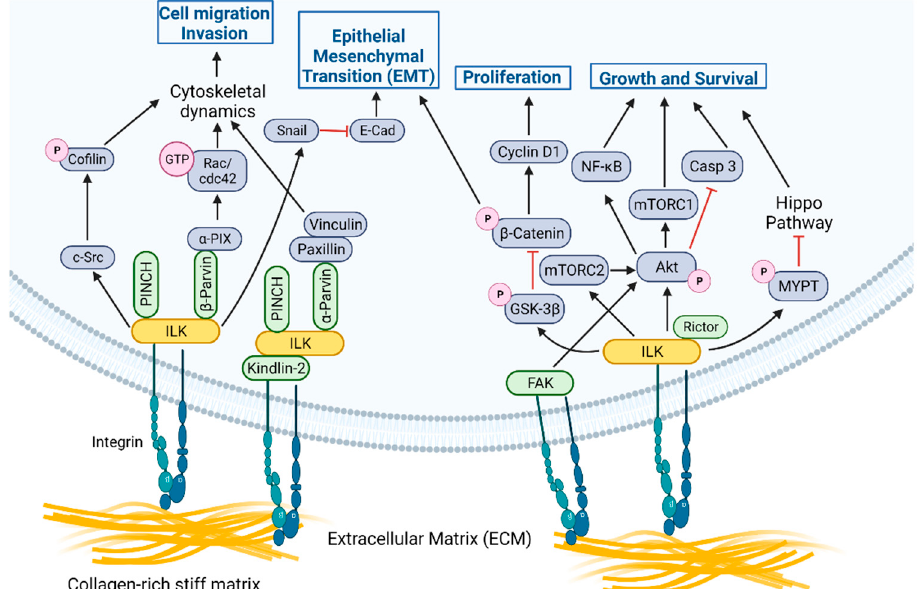
Figure 1. ILK functions as a signaling node at focal adhesions in cells. The ILK-PINCH-Parvin (IPP) complex acts as a structural and signaling hub downstream of integrin-mediated engagement with collagen-rich, stiff ECM [12] to promote processes critical for metastasis, including cytoskeletal dynamics, EMT, migration, and invasion. ILK also promotes phosphorylation of key target proteins essential to processes critical for cancer progression, including survival, proliferation, migration, invasion, and EMT. For the purposes of illustration, we have shown ILK or FAK associated with integrins, but these signaling axes are not mutually exclusive and could be associated in the same complex. Created with Biorender.com. Available online: https://biorender.com/ (accessed on 21 June 2022).